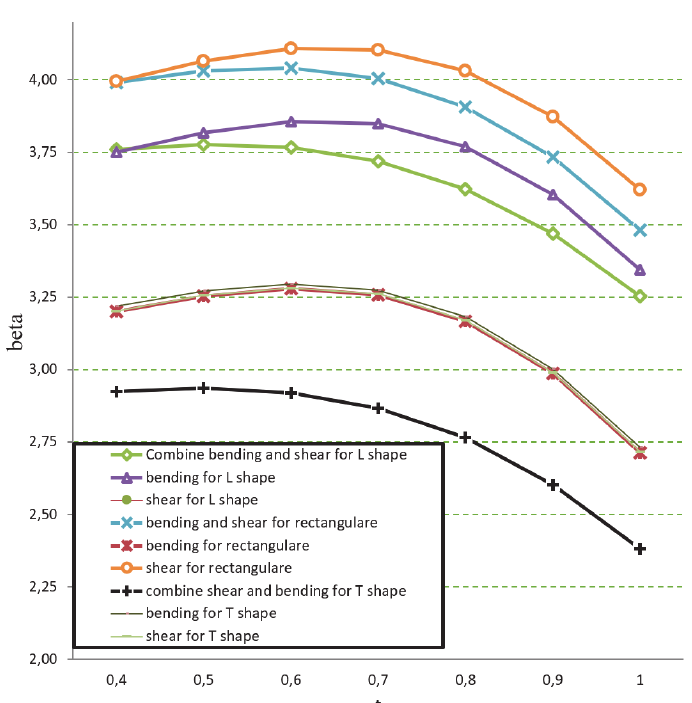
Figure 6: ACI beta index for